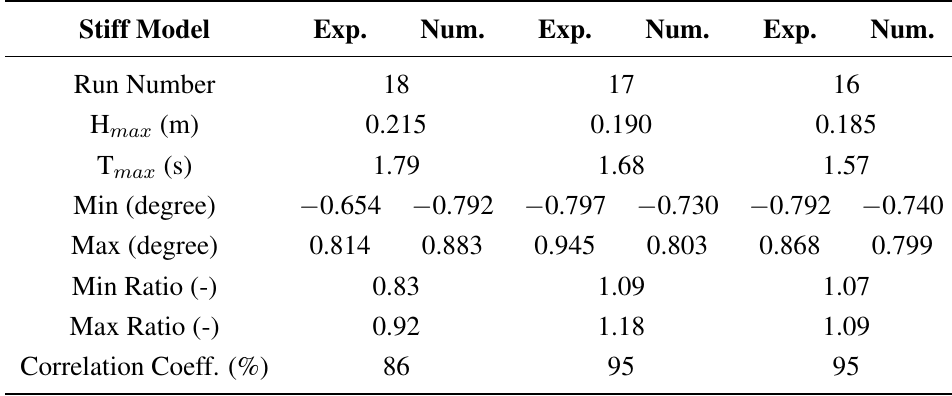
Table 4. Comparison of key data for the pitch motion of the stiff model. Experimental (Exp.) and numerical (Num.) data.